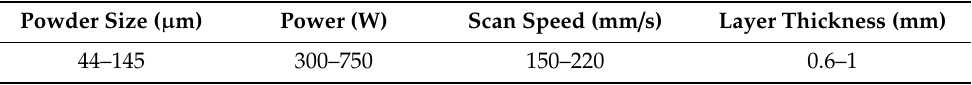
Table 1. Process conditions employed in the laser metal